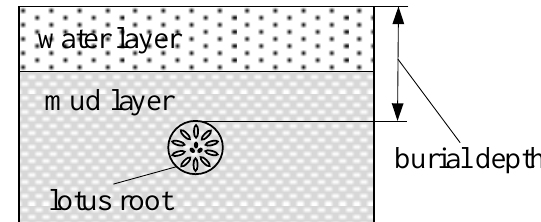
Figure 4. Definition of the burial depth.